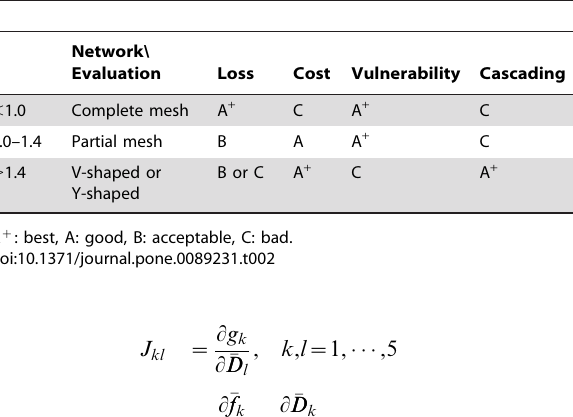
Table 2. Evaluation of the network type for each item.